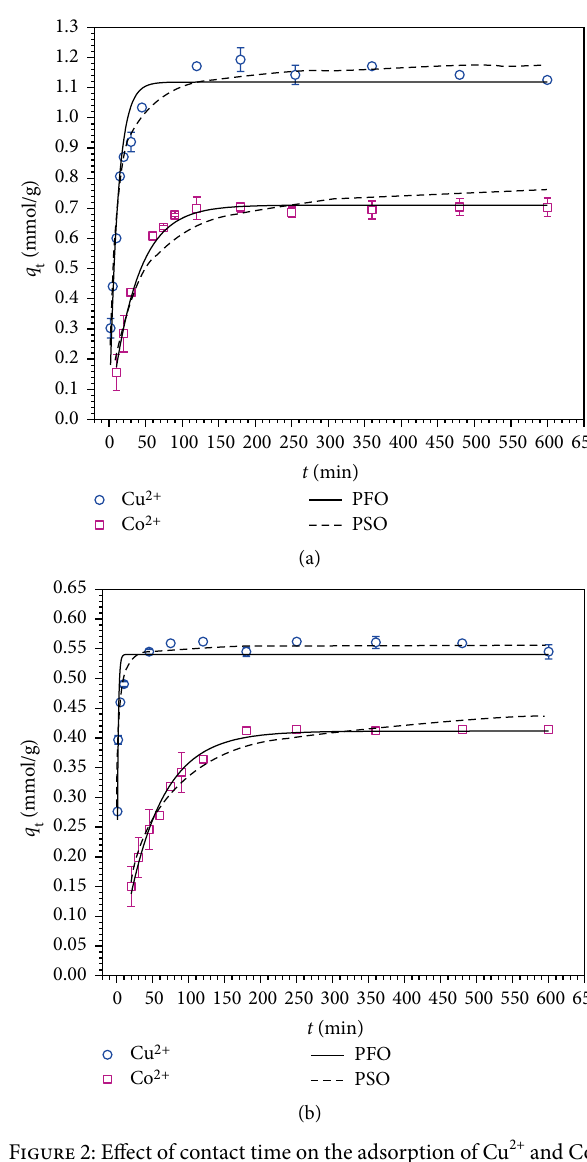
Figure 2: Effect of contact time on the adsorption of Cu 2+ and Co 2+ on (a) Cox and (b) SBox (25°C, 150 rpm, pH 5.5, 0.79 mmol/L Cu 2+ , 0.85 mmol/L Co 2+ , 0.2 g/L Cox or